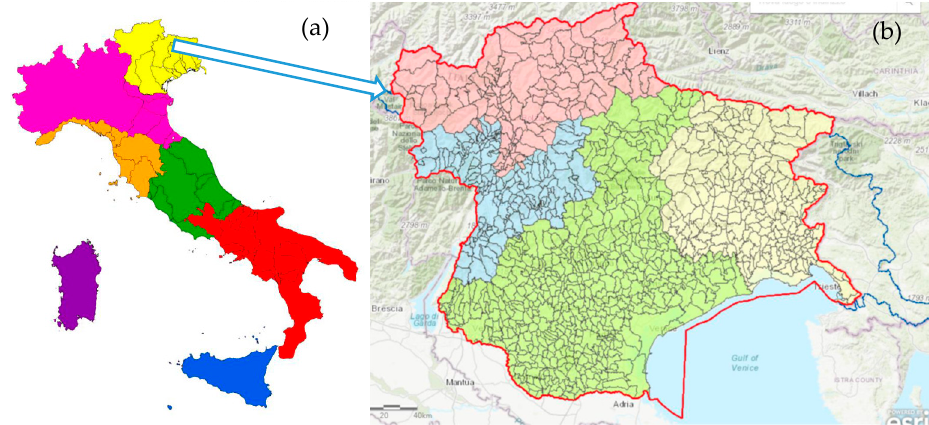
Figure 2. ( a ) Italian river basin districts (RBDs); and ( b ) Eastern Alps RBD: The red line is the border of the RBD, the blue line is the international border of the RBD, the different colors represent the four regional administrations. Source: (a) ISPRA; (b) www.alpirorientali.it.